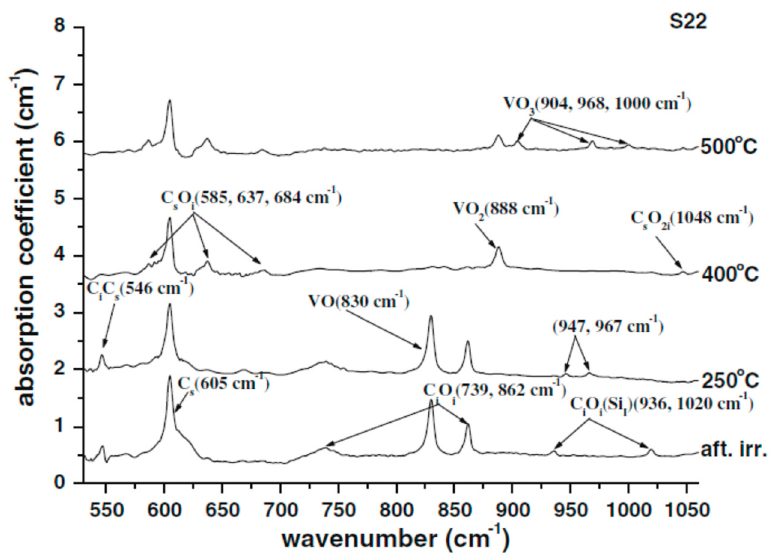
Figure 16. IR spectra of the S22 sample after irradiation and at characteristic temperatures in the course of the isochronal anneals. Reproduced with permission from [44].